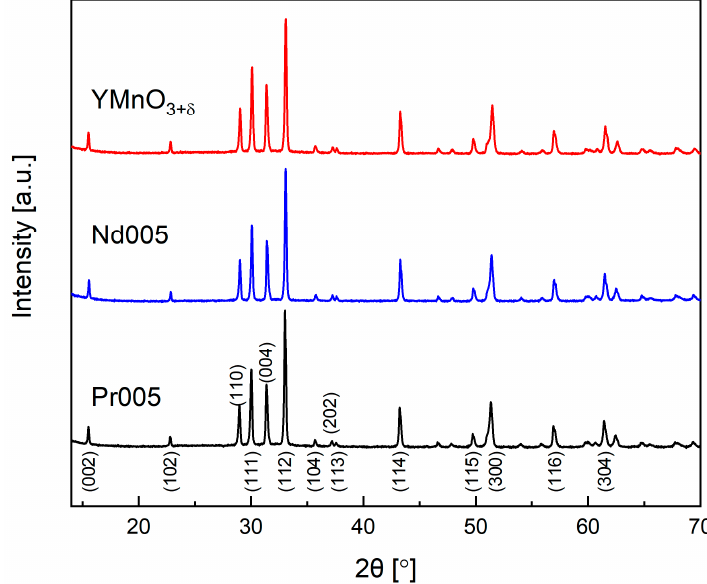
3+ δ , Nd005, and Pr005.